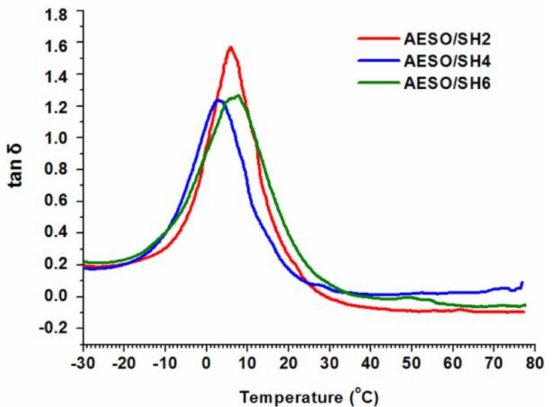
Figure 3. The tan δ versus temperature curves of cross-linked polymers prepared from different